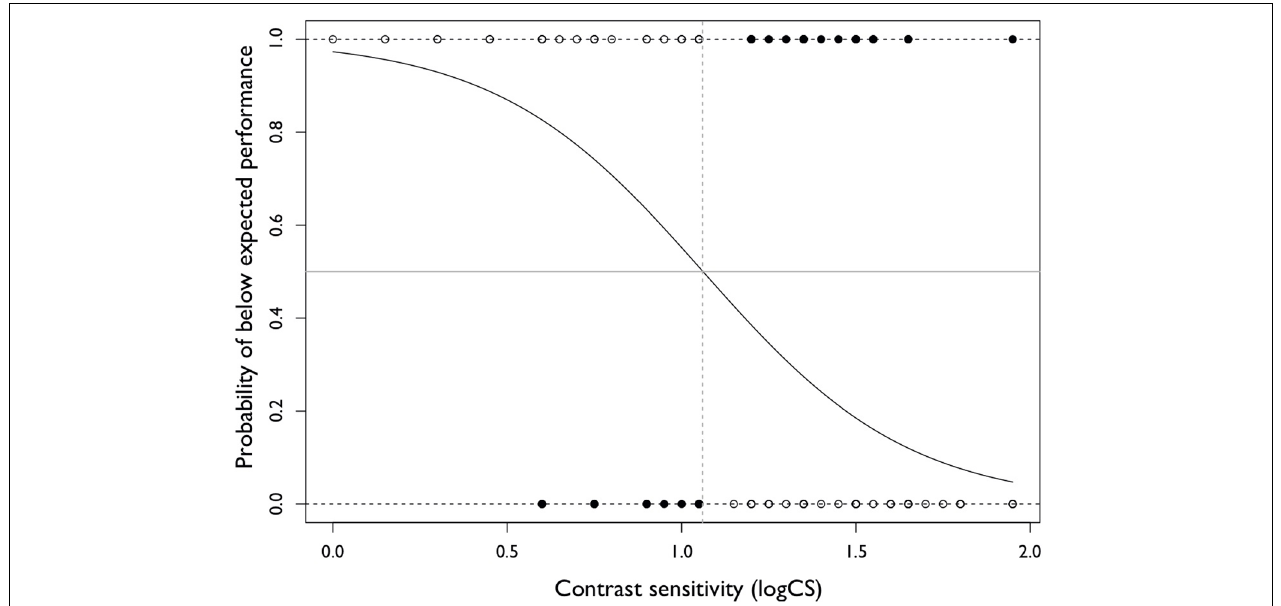
FIGURE 3 | Logistic regression model including CS only. The curve represents the logistic regression model. The horizontal gray line indicates the probability of below expected performance of 0.5 and the vertical dashed gray line indicates the cut off for CS where the probability of below expected performance is 0.5. The open circles indicate observations for which performance is correctly predicted by the CS cut-off and the filled circles indicate observations where performance is incorrectly predicted.